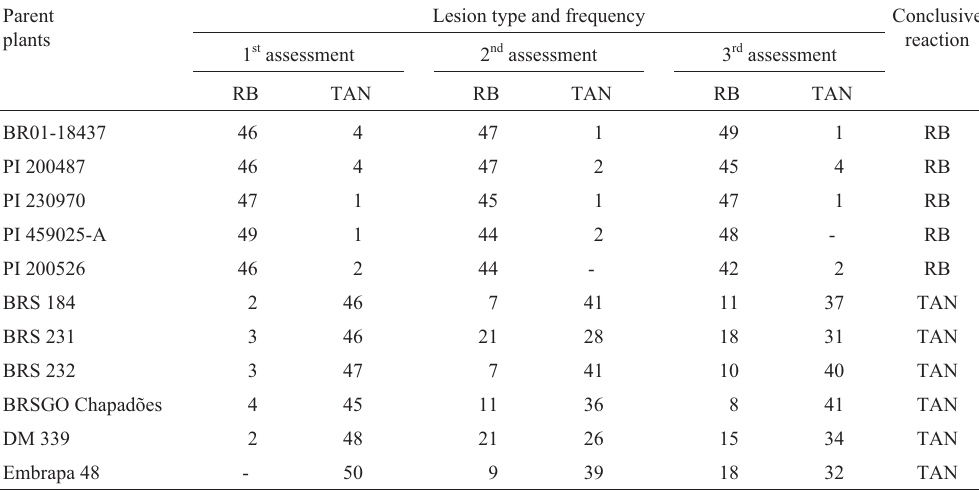
13:3 for the third (Table 2), showing that these genes segre- gated independently. 2 crosses. The table shows the type of lesion re- Lesion type and